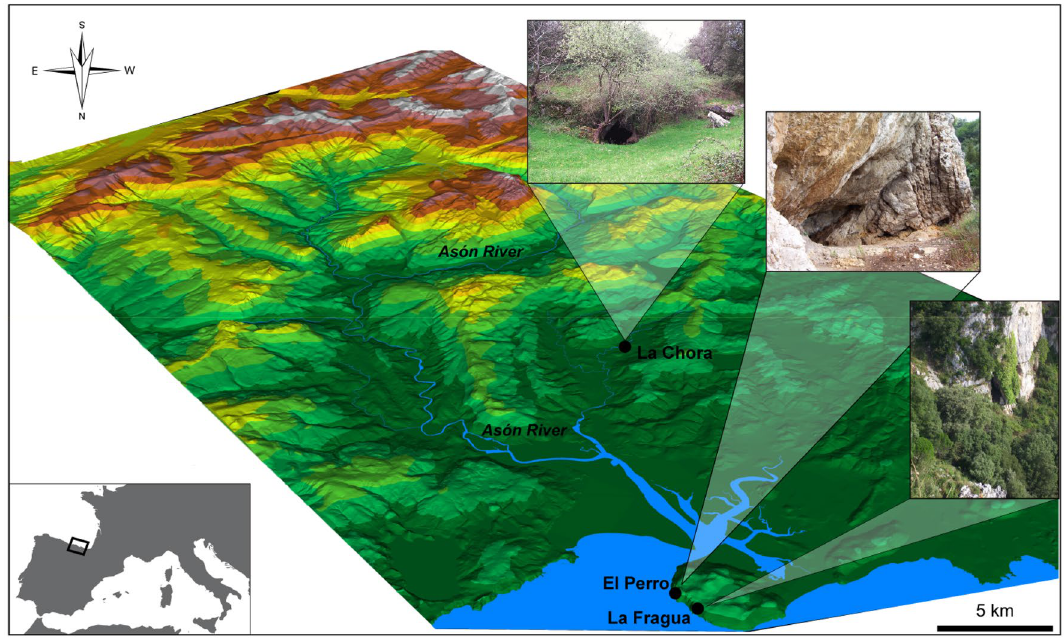
Figure 1. Location of the three studied archaeological shell middens (El Perro, La Fragua and La Chora) in the Asón River basin, in Cantabria, Northern Spain. Map produced using ArcMap 10.6 (ESRI, https:// www. esri. com/ en- us/ arcgis/ produ cts/ arcgis- deskt op/ resou rces) using the DTM25 cartography as base for the Digital Terrain Model (DTM), scale 1:25,000 with ETRS89 reference system of the National Geographic Institute of